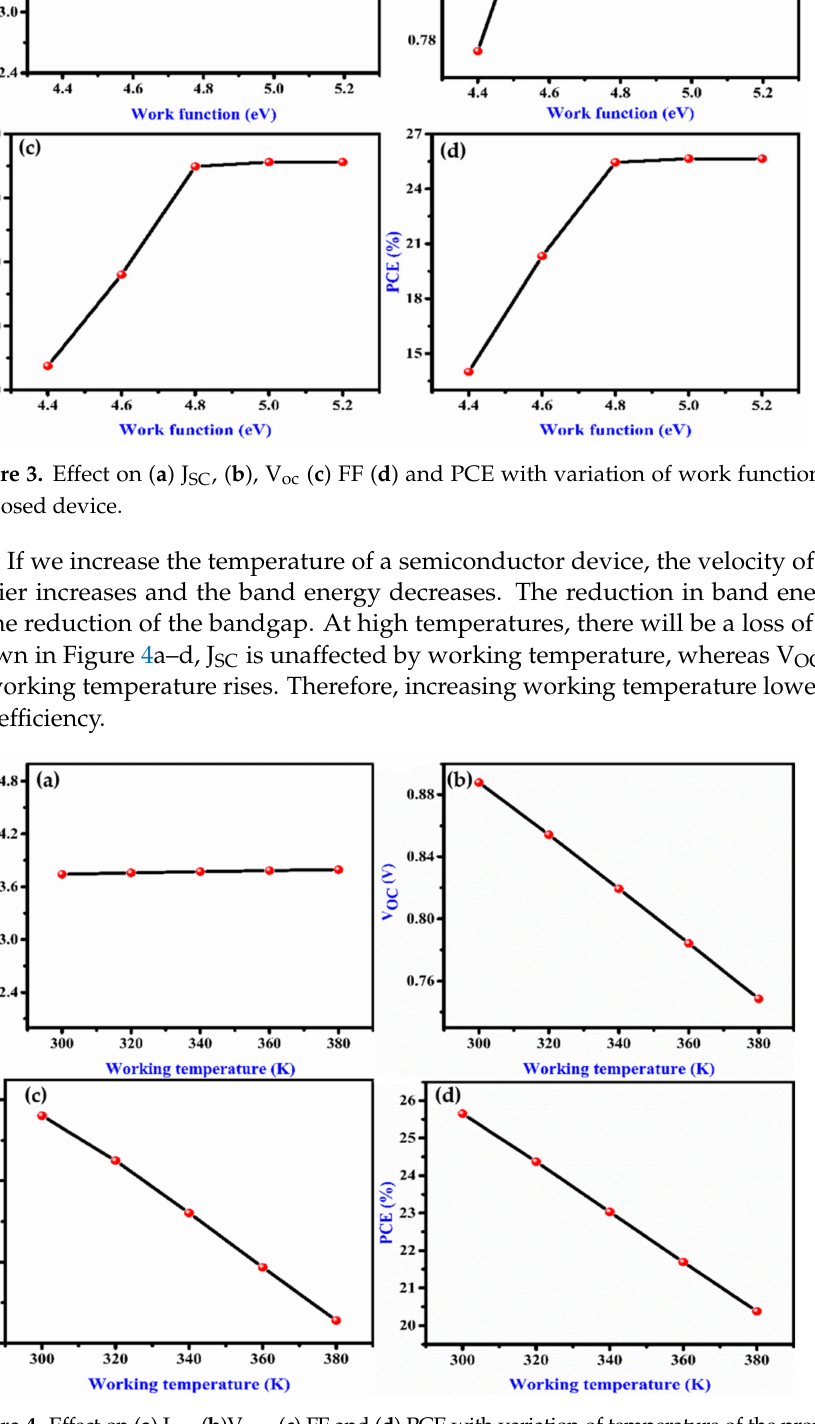
Figure 4. Effect on ( a ) J SC , ( b )V OC , ( c ) FF and ( d ) PCE with variation of temperature of the proposed